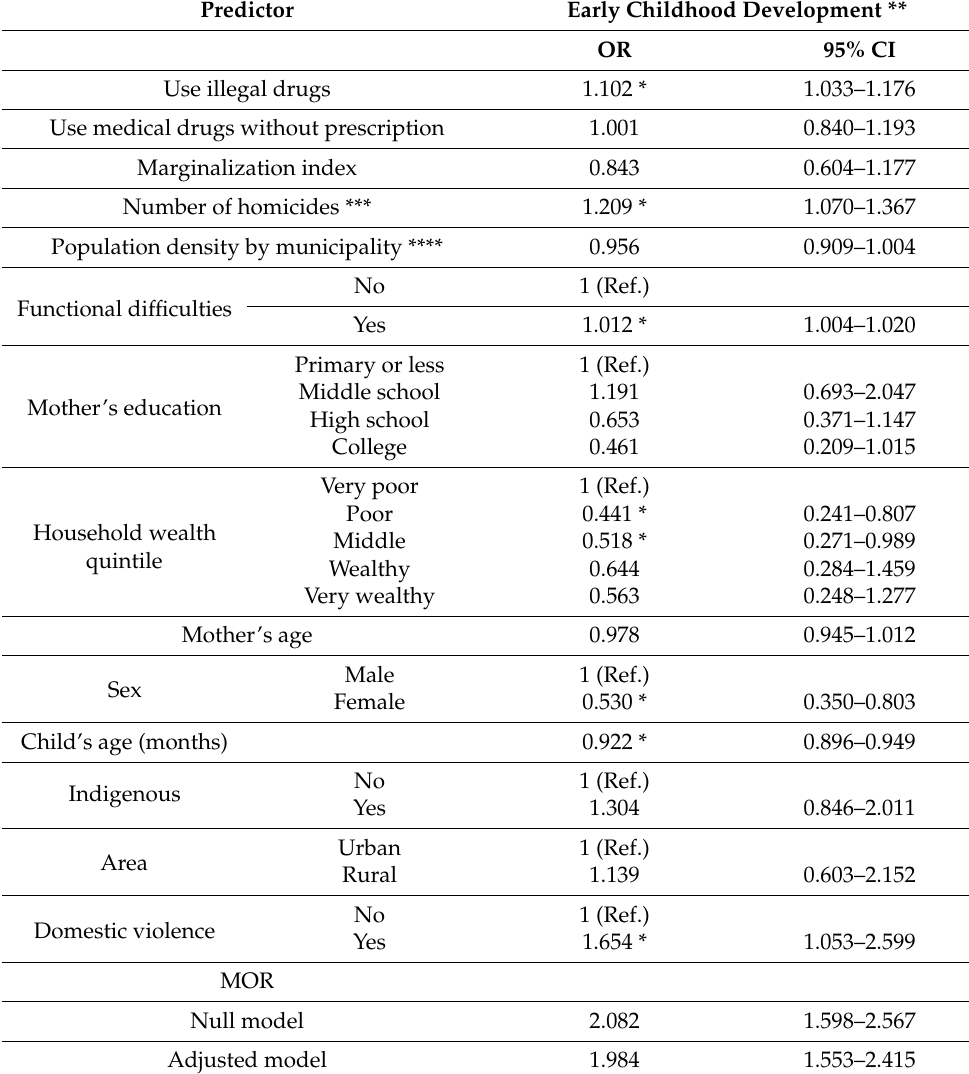
Table 3. Adjusted Associations Between Overall Inadequate Early Childhood Development and Psychoactive Substance Use.